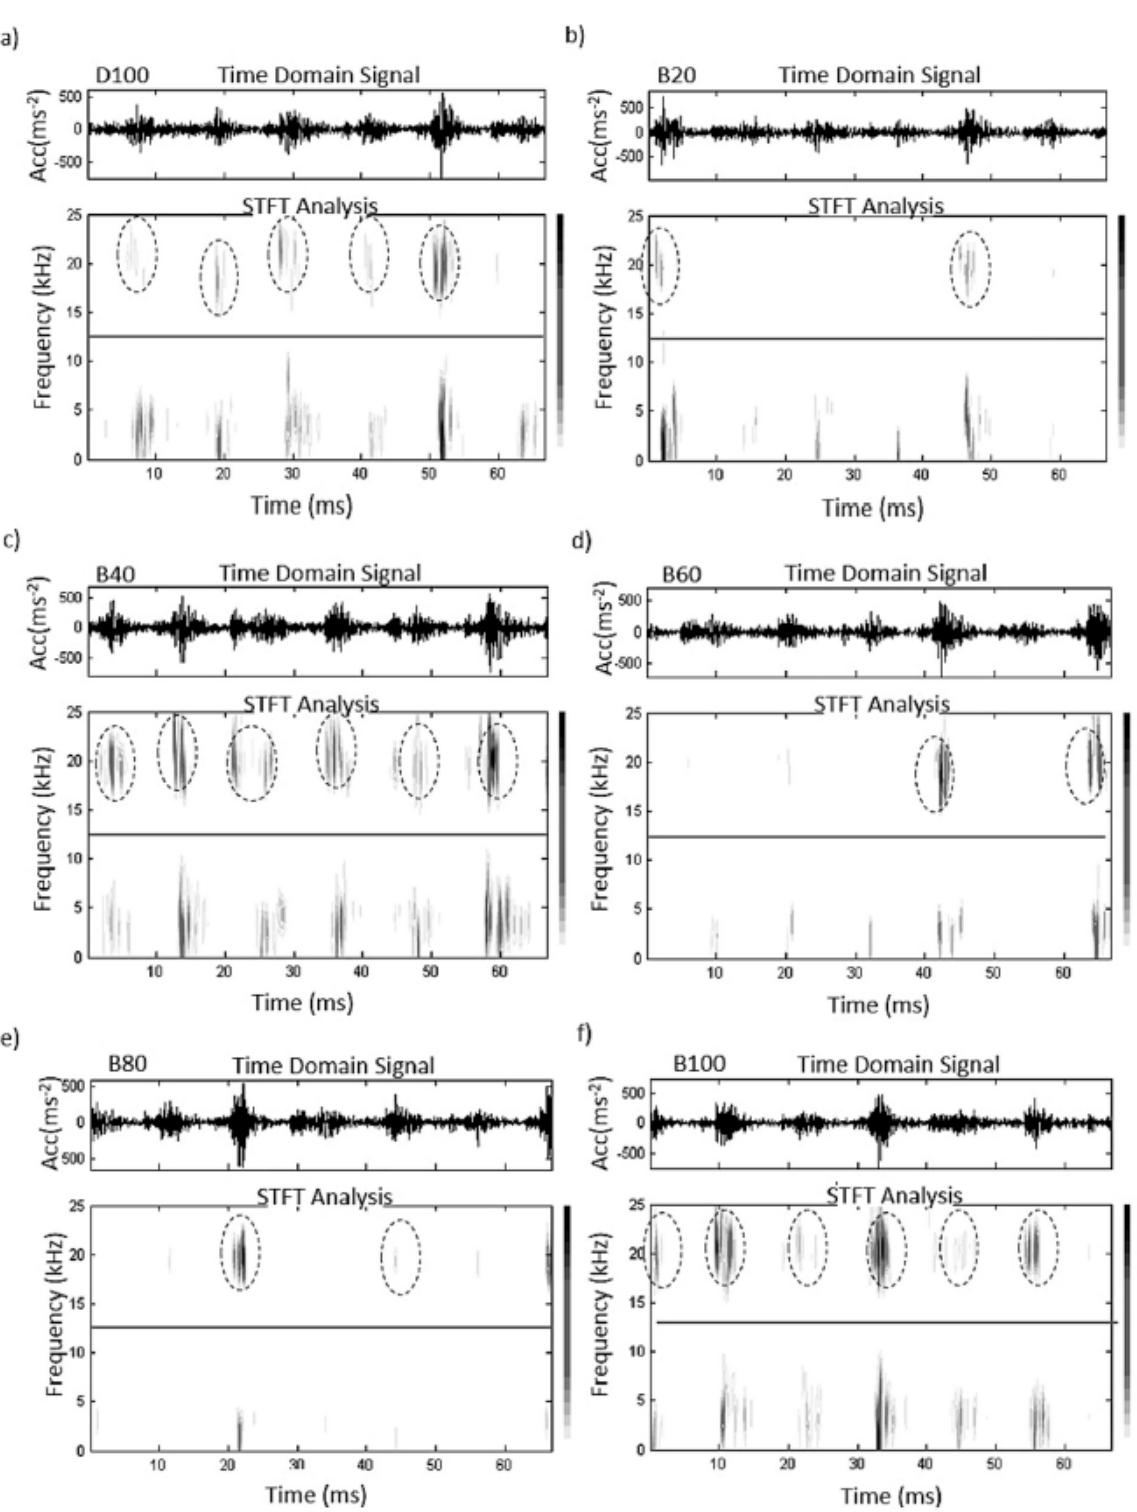
Figure 19. The short-time Fourier transform (STFT) analysis of vibration signals of the six-cylinder engine, running under the full-load condition at 1800 rpm, for different biodiesel–diesel fuel blends [60]. Figures are reprinted with permission from publisher.